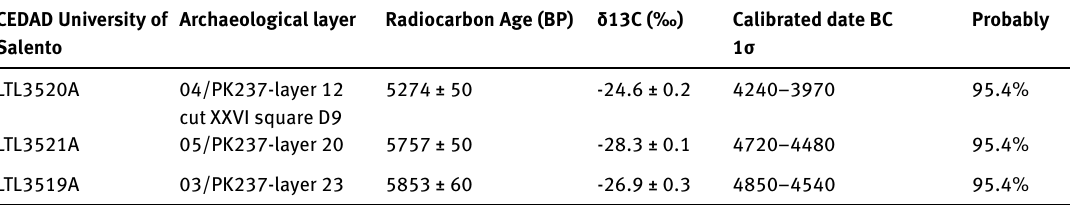
Table 2. Radiocarbon dating by CEDAD laboratory (Salento